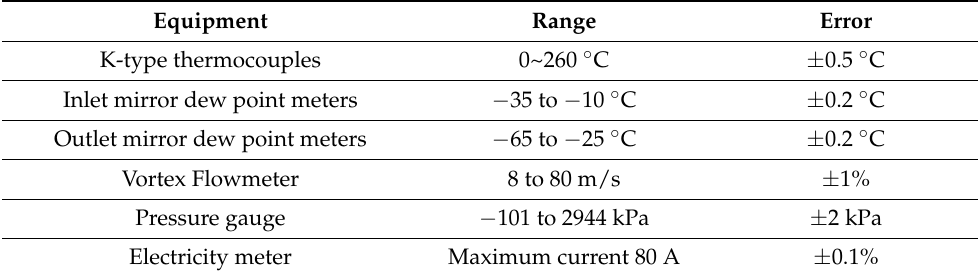
Table 3. Measurement devices used in the